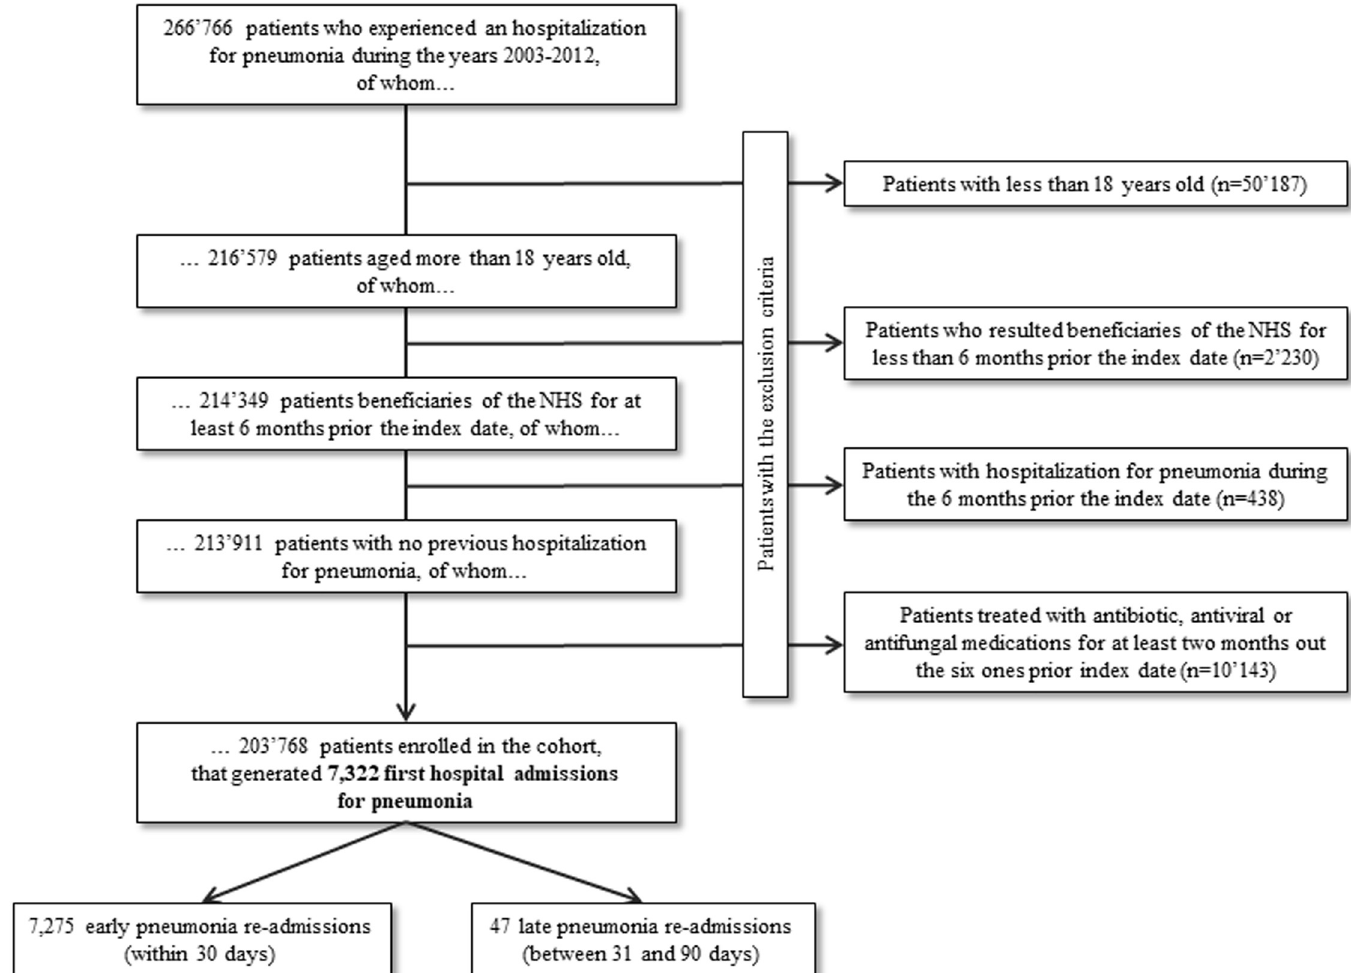
Fig 1. Flow-chart of inclusion and exclusion criteria for the study cohort selection. Lombardy region, Italy, 2003–2012. NHS, national health system.